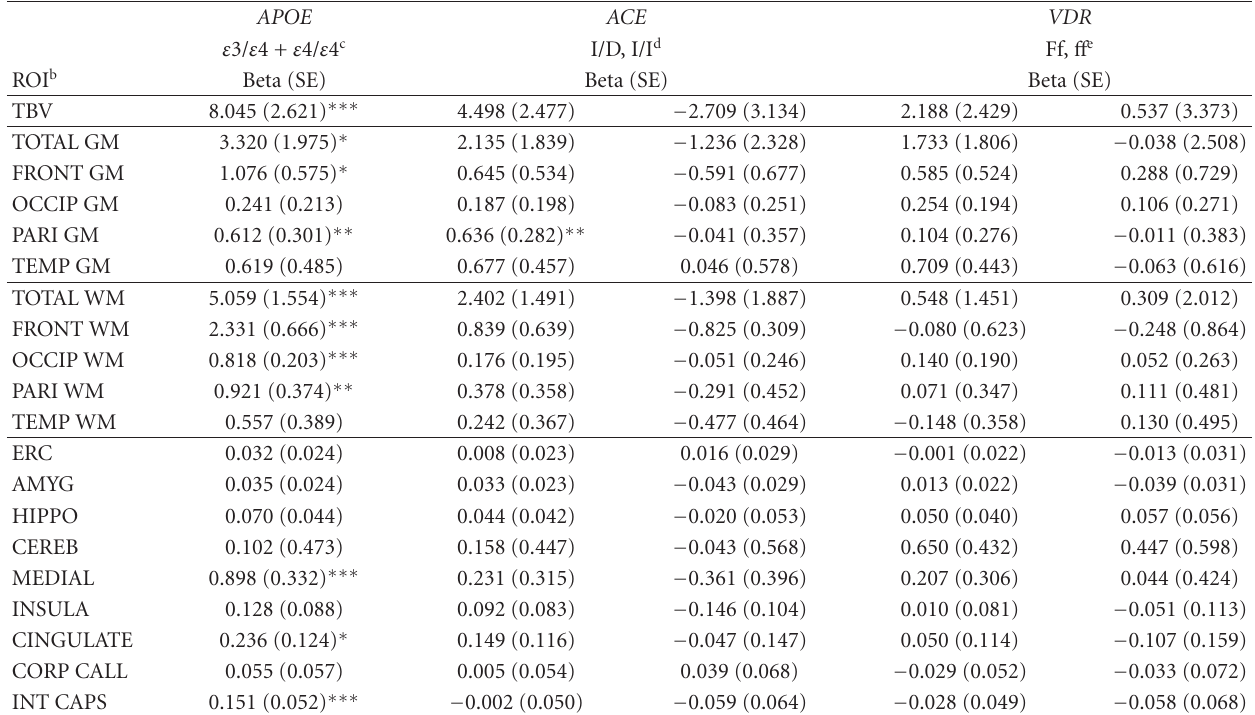
Table 2: Regression a results for delta ROI models for former lead workers and controls ( N = 352), adjusting for confounding